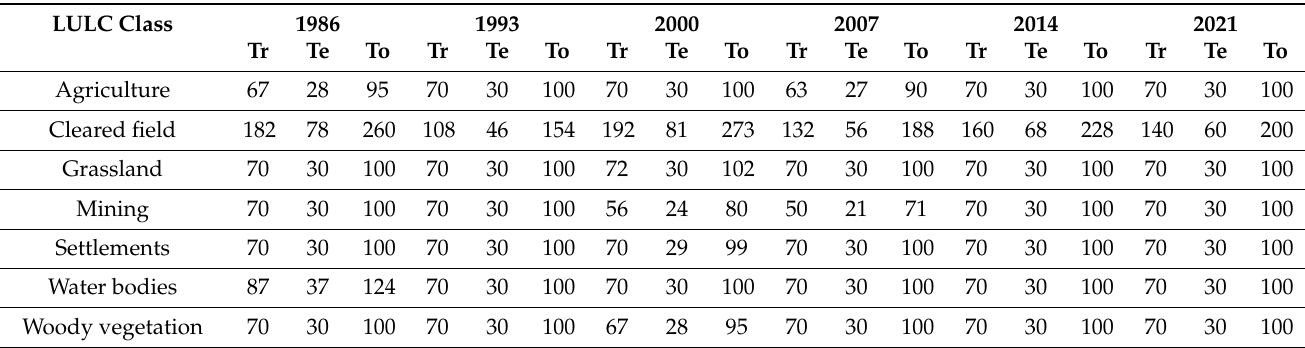
Table 3. The reference data numbers used in this study. Training data (Tr), test data (Te) and total number of data points